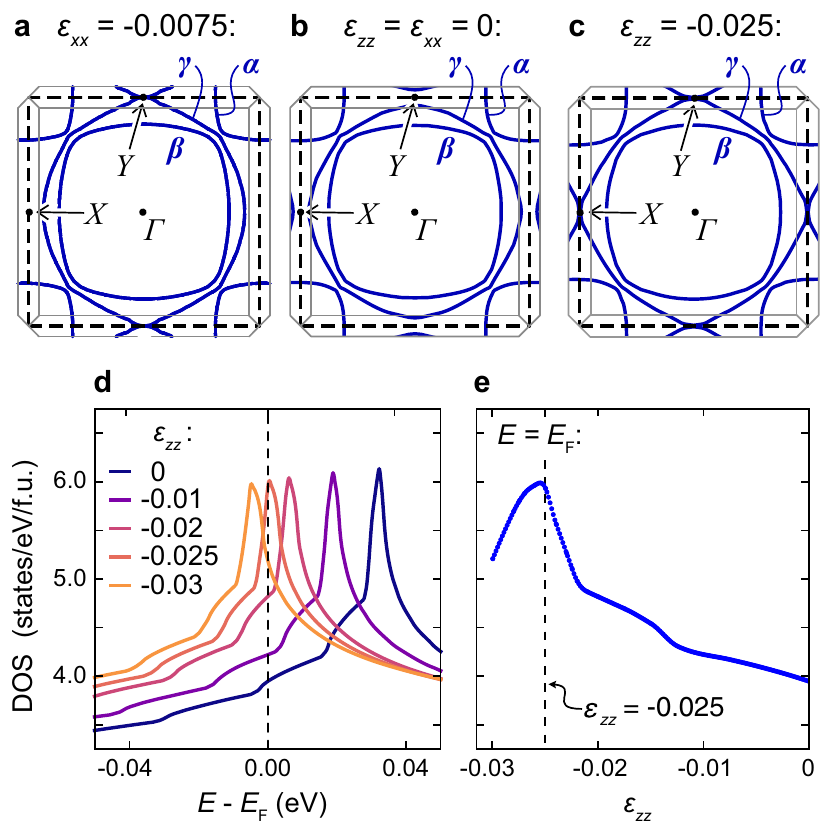
Fig.1|ElectronicstructurecalculationsofstrainedSr 2 RuO 4 .a – c Cross-sections at k z =0 of calculated Fermi surfaces of Sr 2 RuO 4 at the indicated strains. The heavy dashed lines indicate the zone of the RuO 2 sheet, and the thin gray lines the 3D zone of Sr 2 RuO 4 . X and Y label high-symmetry points of the RuO 2 zone. (To simplify discussion, we refer throughout this paper to the X and Y points de fi ned in the 2D zone, rather than the points of the full 3D zone). a The